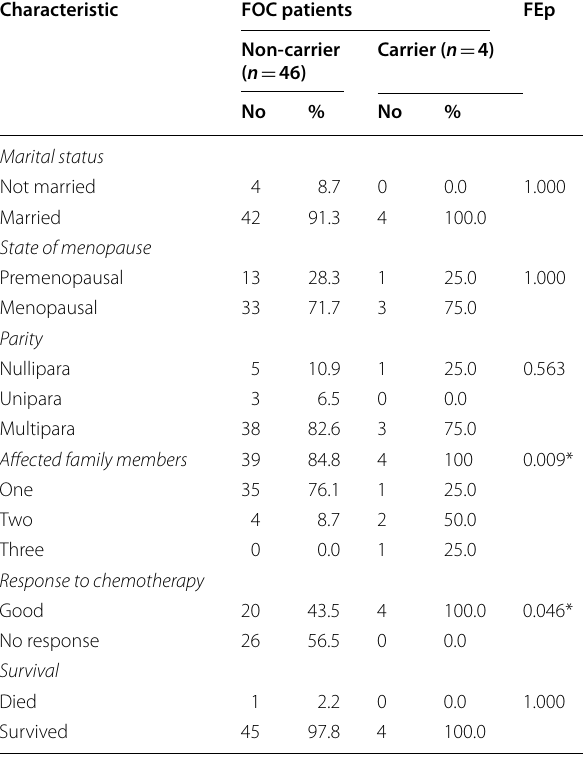
Table 2 Comparison between BRCA1 5382insC carriers